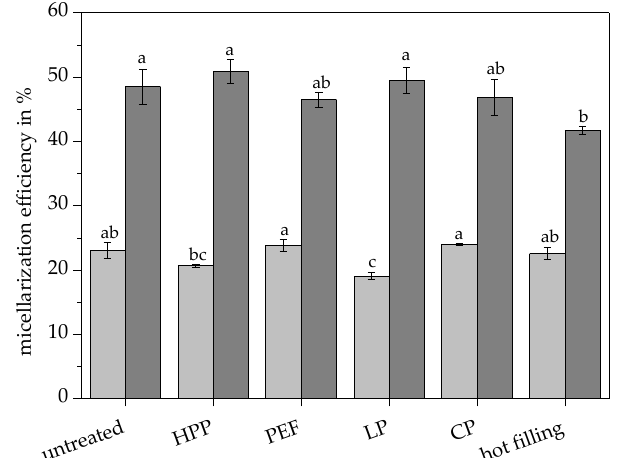
Figure 5. Carotenoid micellarization e ffi ciencies in the untreated and pasteurized orange juices without ( (cid:4) ) and with ( (cid:4) ) additional ultrasonication. Di ff erent letters indicate significant di ff erences ( p ≤ 0.05). Values are means ± standard deviation (n = 3).